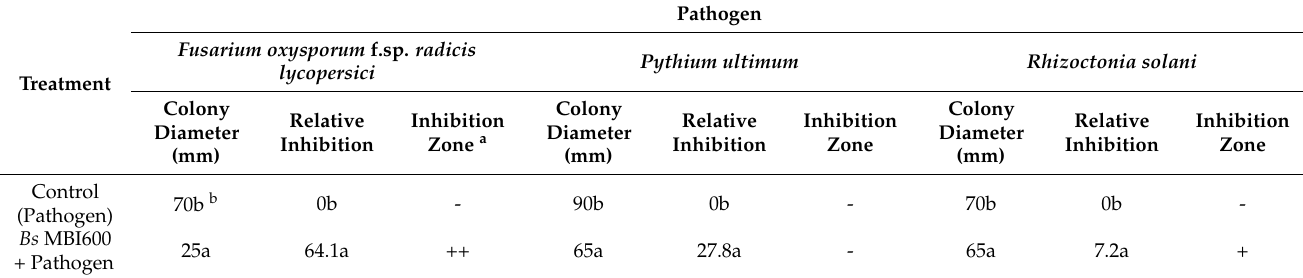
a Diameter (mm) of inhibition zone between pathogens and Bs MBI600 on PDA plates: - no inhibition; + inhibition zone of <10mm; ++ inhibition zone of >10 mm. b Mean values followed by different letters in the column indicate significant differences among treatments according to Fisher’s LSD test ( p <